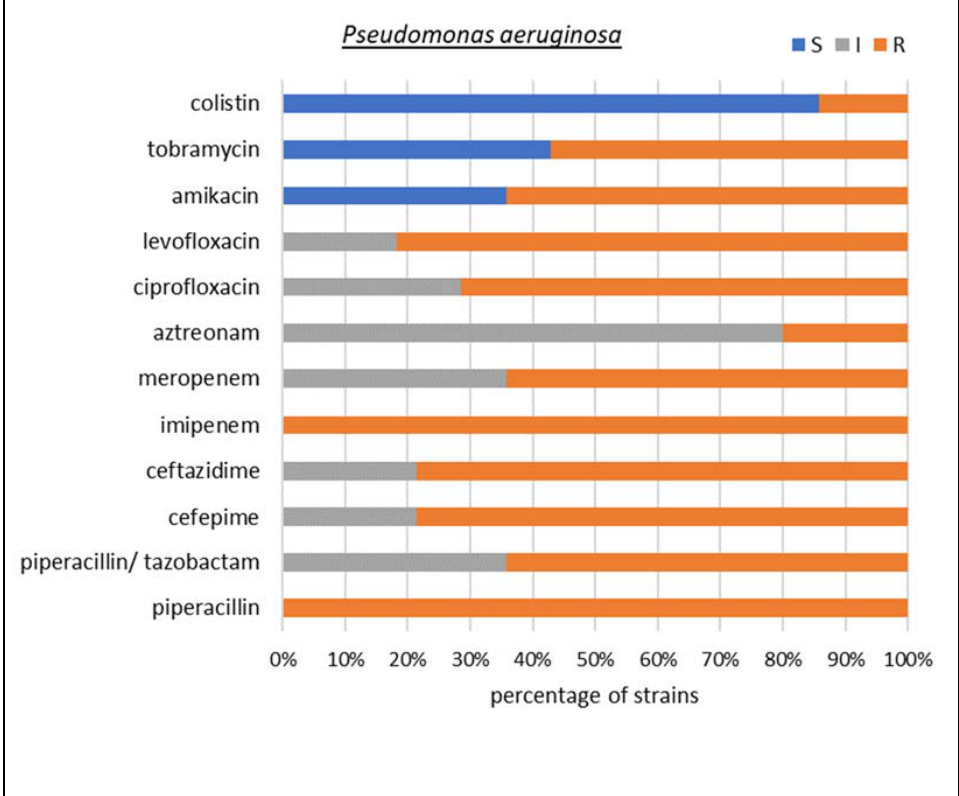
Figure 8. Drug susceptibility of the studied Pseudomonas aeruginosa strains producing car- bapenemases ( n = 15).